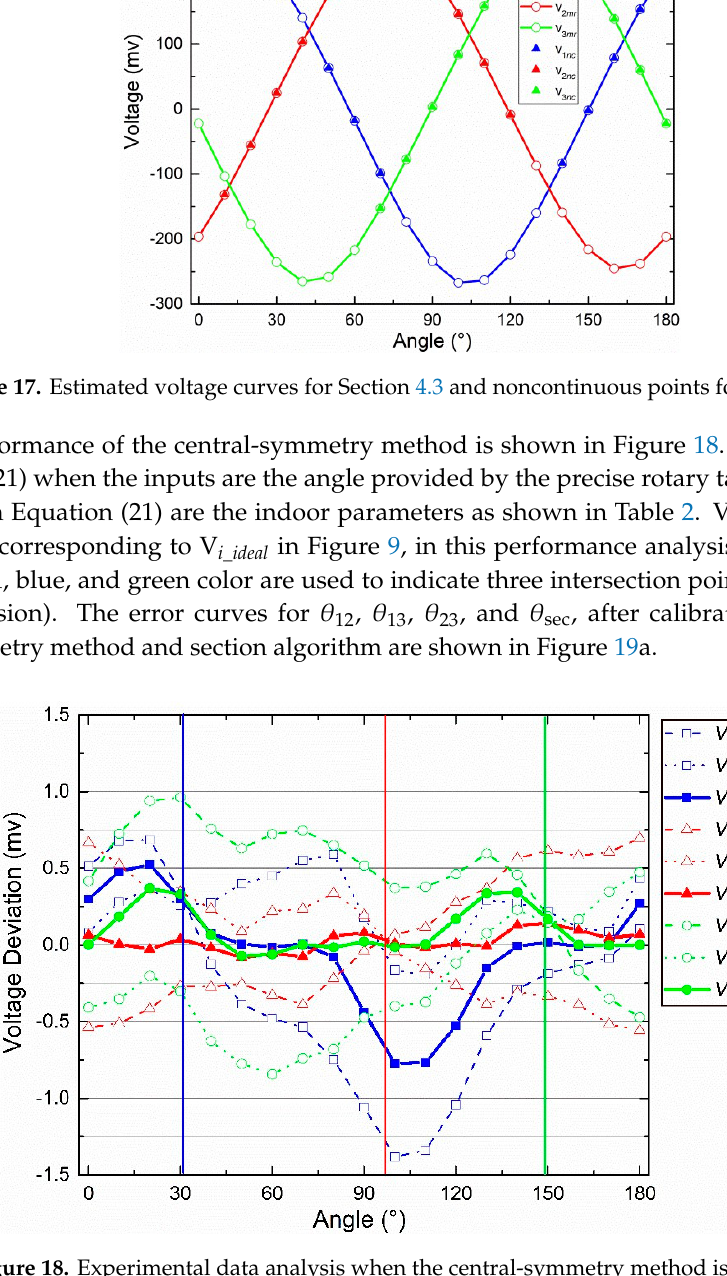
Figure 16. Error curves when only the section algorithm is used.